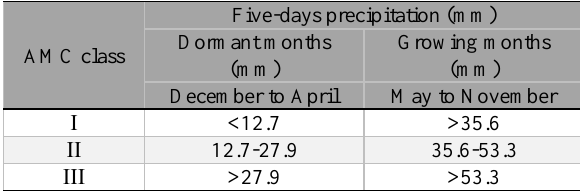
Table 2. Determination of AMC class based on the precipitation of the five days (SCS 1985).